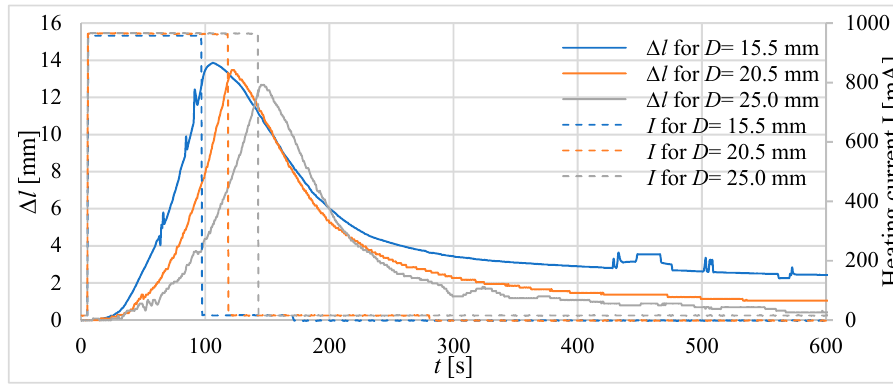
Figure 12. Absolute elongation for tube actuators of equal length and different diameters.